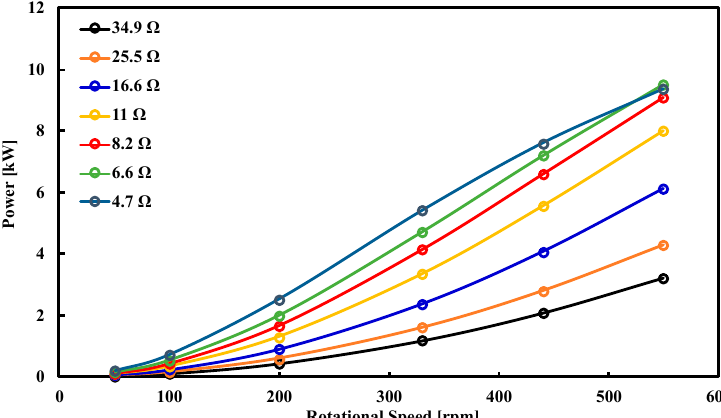
Figure 17. Measured Mechanical load input power and rotational speed of the full-scale generator in various load resistance: R 3ph = 4.7–34.9 Ω .